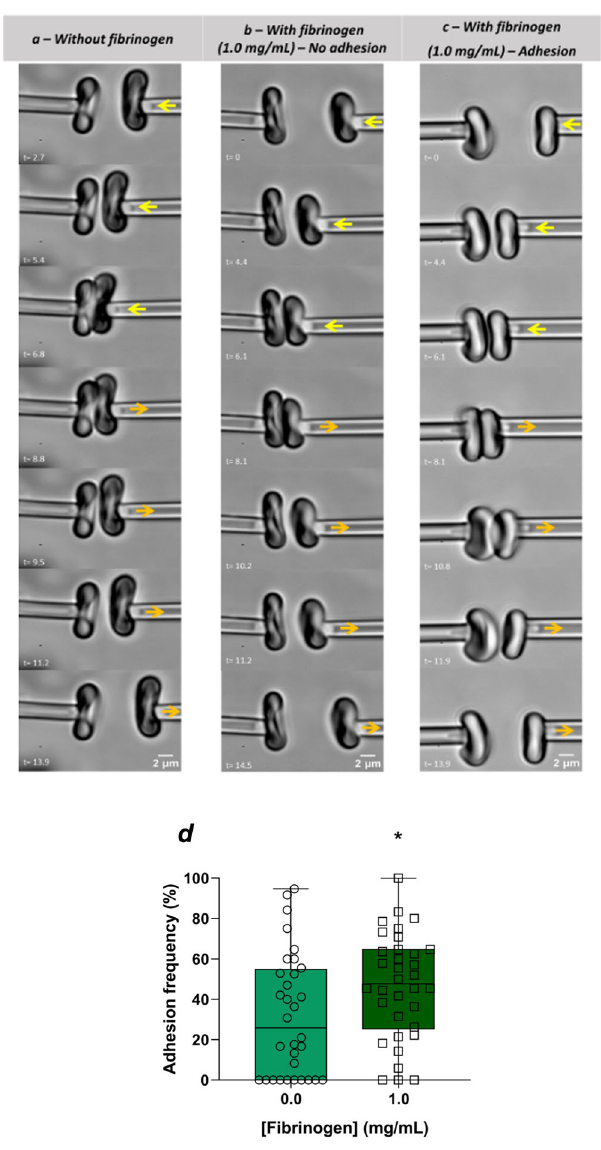
Fig. 2 Sequence of microscopy images of the micropipette aspiration assay and measured erythrocyte – erythrocyte adhesion frequency. Images at different stages of the erythrocyte – erythrocyte adhesion in the absence of fi brinogen ( a ) and in the presence of 1.0 mg/mL of fi brinogen ( b , c ). A negative pressure (20 Pa) was applied to catch an erythrocyte in each micropipette (left side pipette is kept static). The arrows indicate the direction of movement of the erythrocyte on the right. Erythrocyte- erythrocyte adhesion was continuously observed on a digital video for subsequent analysis with LabVIEW. It is possible to observe that in the presence of fi brinogen there was a higher adhesion between erythrocytes, leading to a pulling of the membrane of the erythrocyte of the left side (on the static micropipette) when the erythrocyte from right micropipette is being moved away from it. d Erythrocyte-erythrocyte adhesion frequency. The represented values are the percentage of the adhesion between two erythrocytes from healthy donors. The frequency of adhesion between two erythrocytes in the presence of fi brinogen 1.0 mg/mL is higher than on its absence (46.7 ± 26.0% vs. 32.0 ± 30.4%, respectively; p = 0.04). The total number of erythrocyte pairs analysed, obtained from fi ve healthy donors, were n = 32 and n = 34, with and without fi brinogen addition, respectively. For each erythrocyte pair, we obtained 16 ± 5 adhesion image sequences. Experimental values are presented together with box-and-whiskers plot with the median